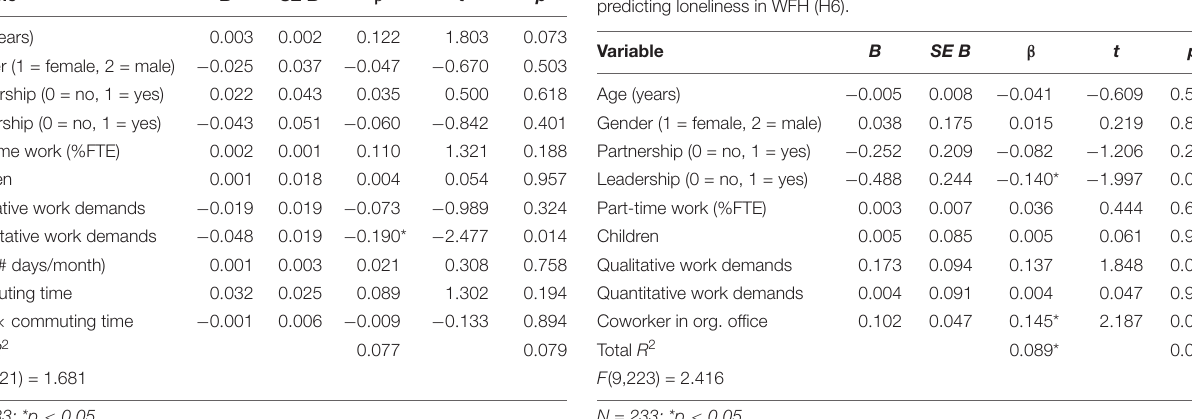
TABLE 7 | Multiple linear regression analysis for coworker in the office on-site predicting loneliness in WFH